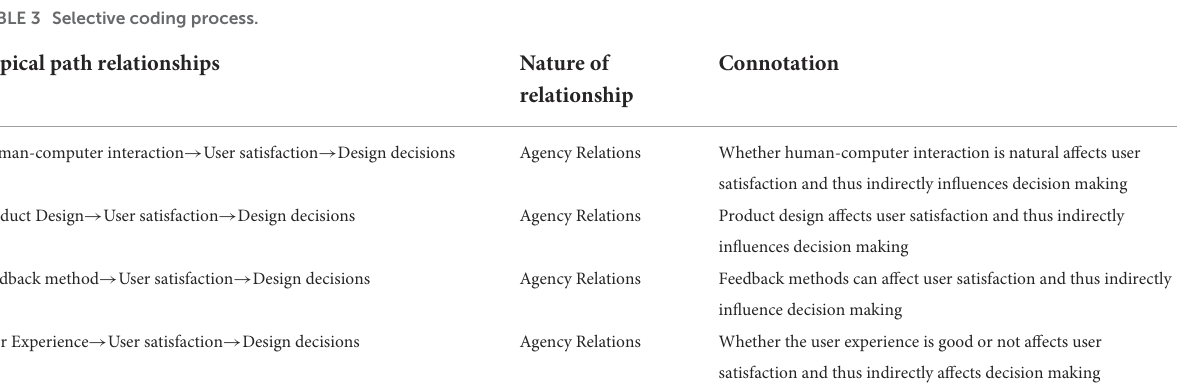
TABLE 3 Selective coding